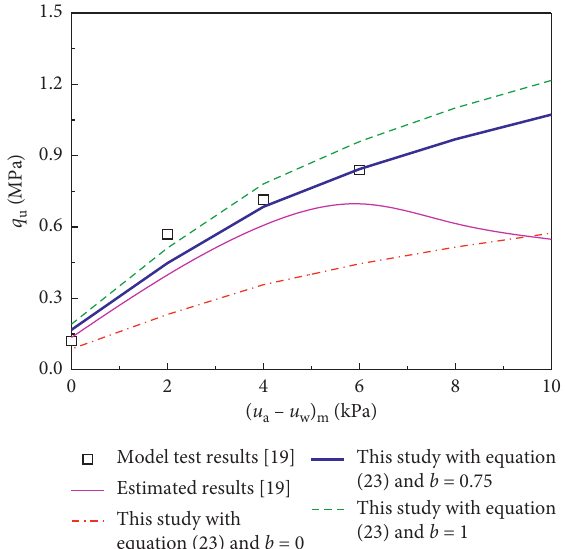
Figure 6: Comparisons with the result of Vanapalli and Mohamed